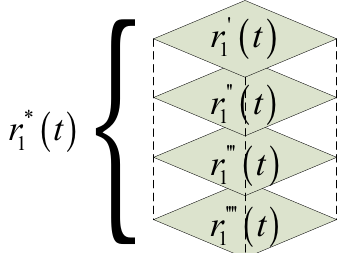
Figure 3. Multilevel regulatory factor.